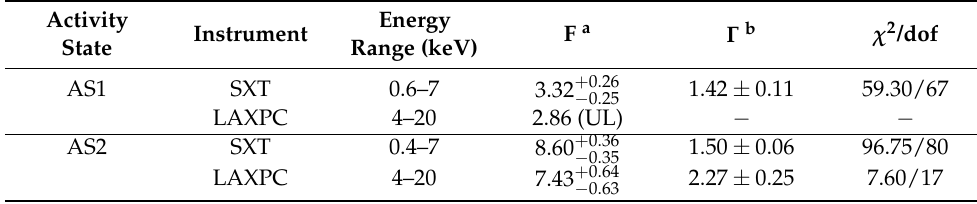
Table 3. AstroSat -SXT and LAXPC analysis results.